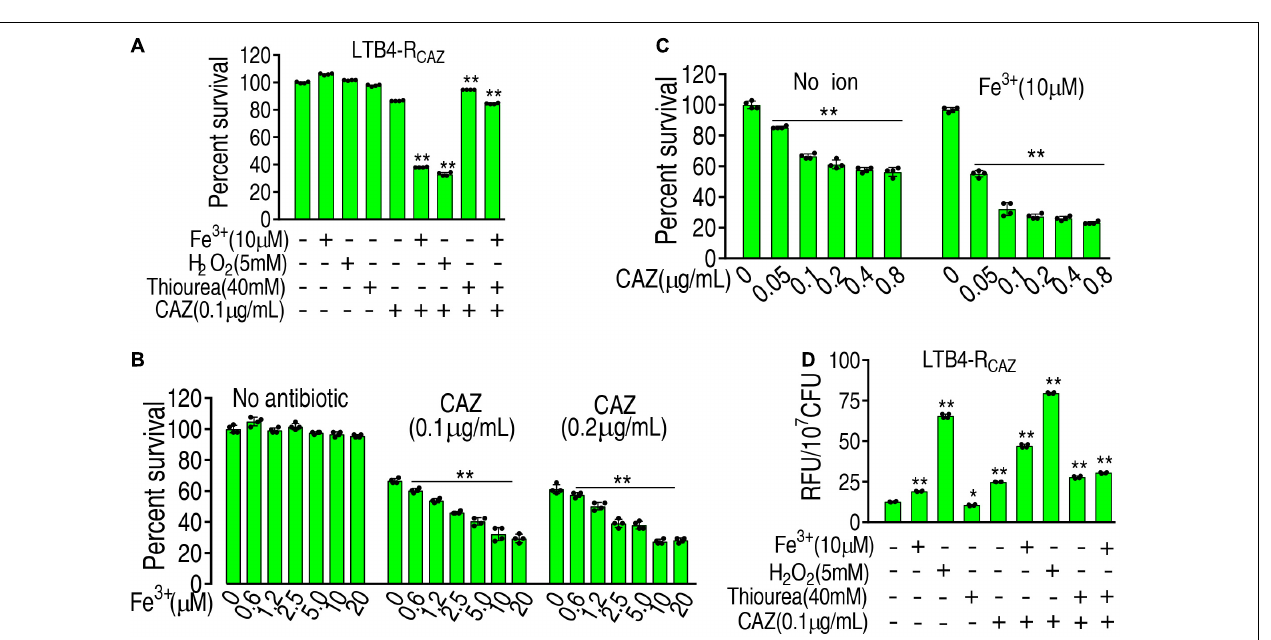
FIGURE 1 | Ceftazidime resistance and reactive oxygen species (ROS) level in LTB4-R CAZ . (A) Minimum inhibitory concentration (MIC) of LTB4-S and LTB4-R CAZ . (B) Killing efficiency of ceftazidime to LTB4-S and LTB4-R CAZ . (C) ROS of LTB4-S and LTB4-R CAZ . Results (B , C) are displayed as mean ± SEM, as determined by two-tailed Student’s t -test. Four biological repeats are carried out. ** P < 0.01.